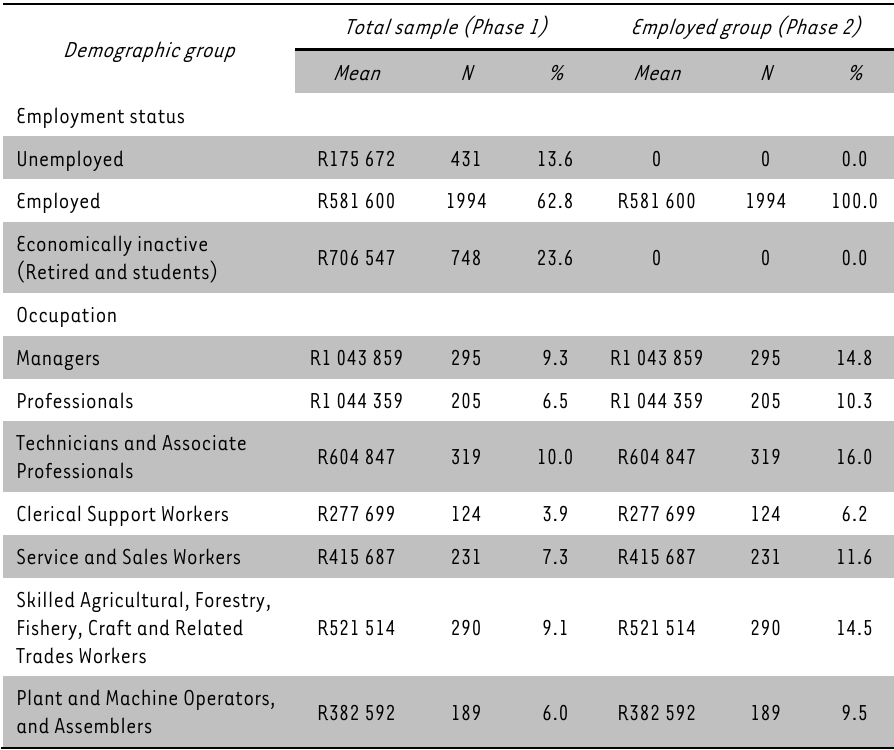
TABLE 4: Demographic profile of respondents Demographic